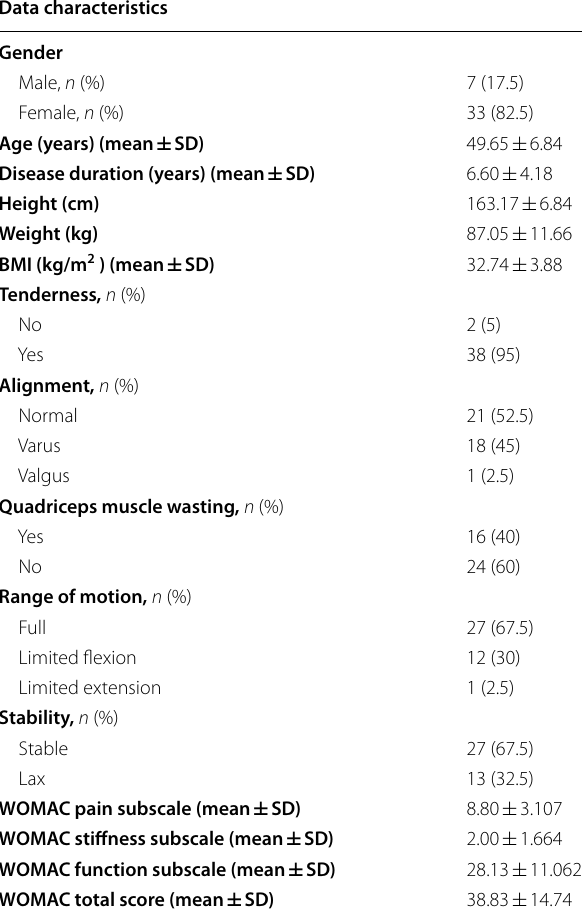
Table 1 Demographic and clinical characteristics of the studied patients